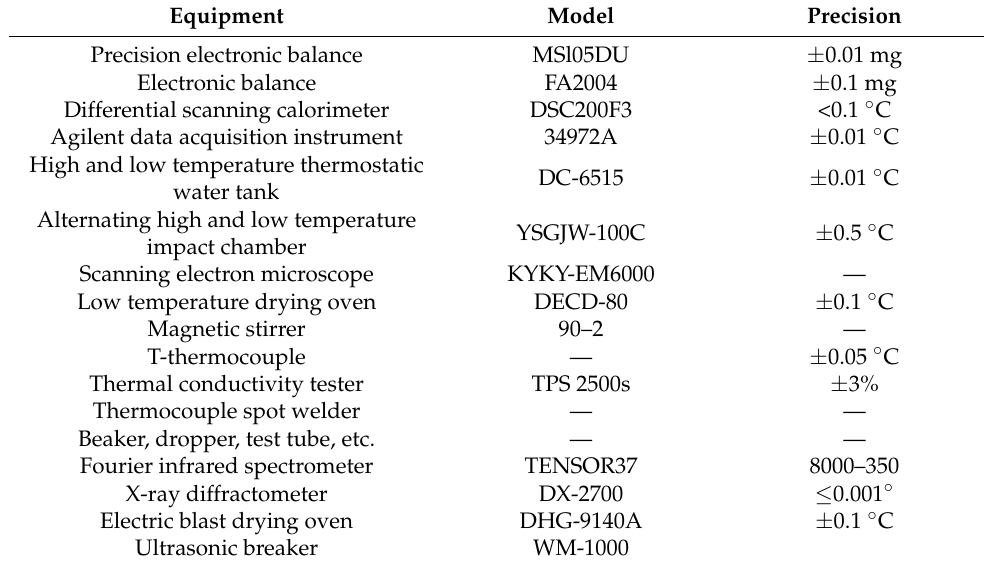
Table 1. Table of experimental